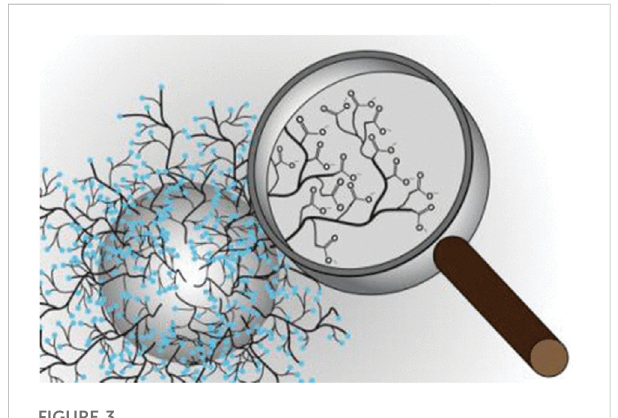
FIGURE 3 Sketch of the surface of a PMMA-bead, showing multiple and irreproducible coordination sites for ions, complexes and other species. Reprinted with permission from Andreas Hennig, Heike Borcherding, Christian Jaeger, et al., Scope and Limitations of Surface Functional Group Quanti fi cation Methods: Exploratory Study with Poly (acrylic acid)-Grafted Micro- and Nanoparticles, J. Amer. Chem. Soc., 2012. 134(19): p. 8268-8276. Copyright 2023 American Chemical Society.